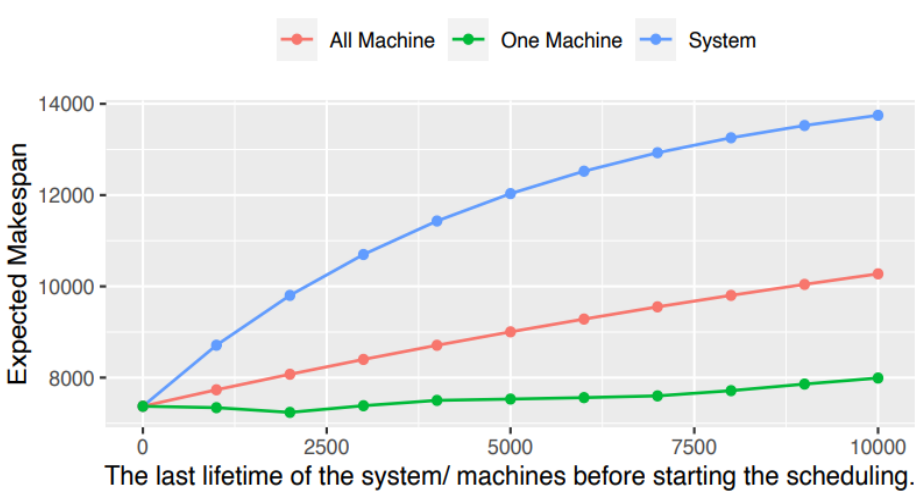
Figure 1. The Expected makespan of the system with the interval [0,10k] that indicates the last lifetime of the system/machines spent before executing the Car2 problem. In this figure 𝑷 𝒊𝒋∗ (𝒕)~ 𝑵 (𝑷 blue line represents the Expected makespan computed according to the robust procedure in Proposition 1 and the orange one is devoted to illustrating the robust procedure in Proposition 2 applied to all machines in the system, while the green line is devoted to machine 3 in the